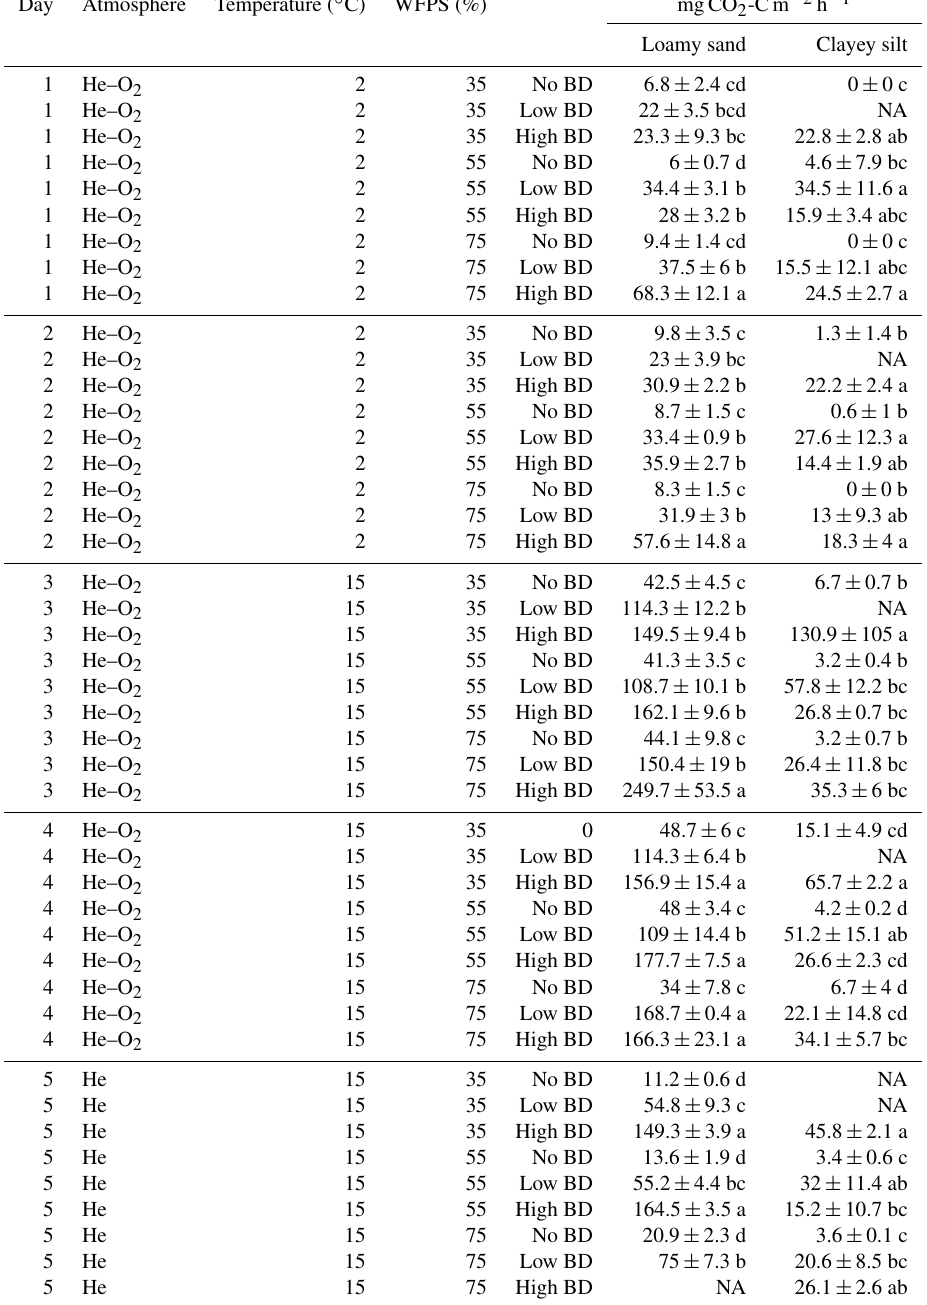
Table A1. Mean CO 2 -C fluxes with standard deviations in mgm − 2 h − 1 from the loamy sand and the clayey silt, treated with different water- filled pore spaces (WFPSs, %), amounts of digestate (0mL per sample ring: no BD, 17.6mL: low BD and 35.2mL: high BD) and different temperature regimes ( ◦ C) under aerobic (He–O 2 ) and anaerobic (He) atmospheres. The column “Day” denotes the consecutive measuring days of the respective incubation cycle. Different letters after fluxes indicate significant differences (Tukey’s HSD, p < 0.05) within each soil and measuring day. Zeros as last digits were